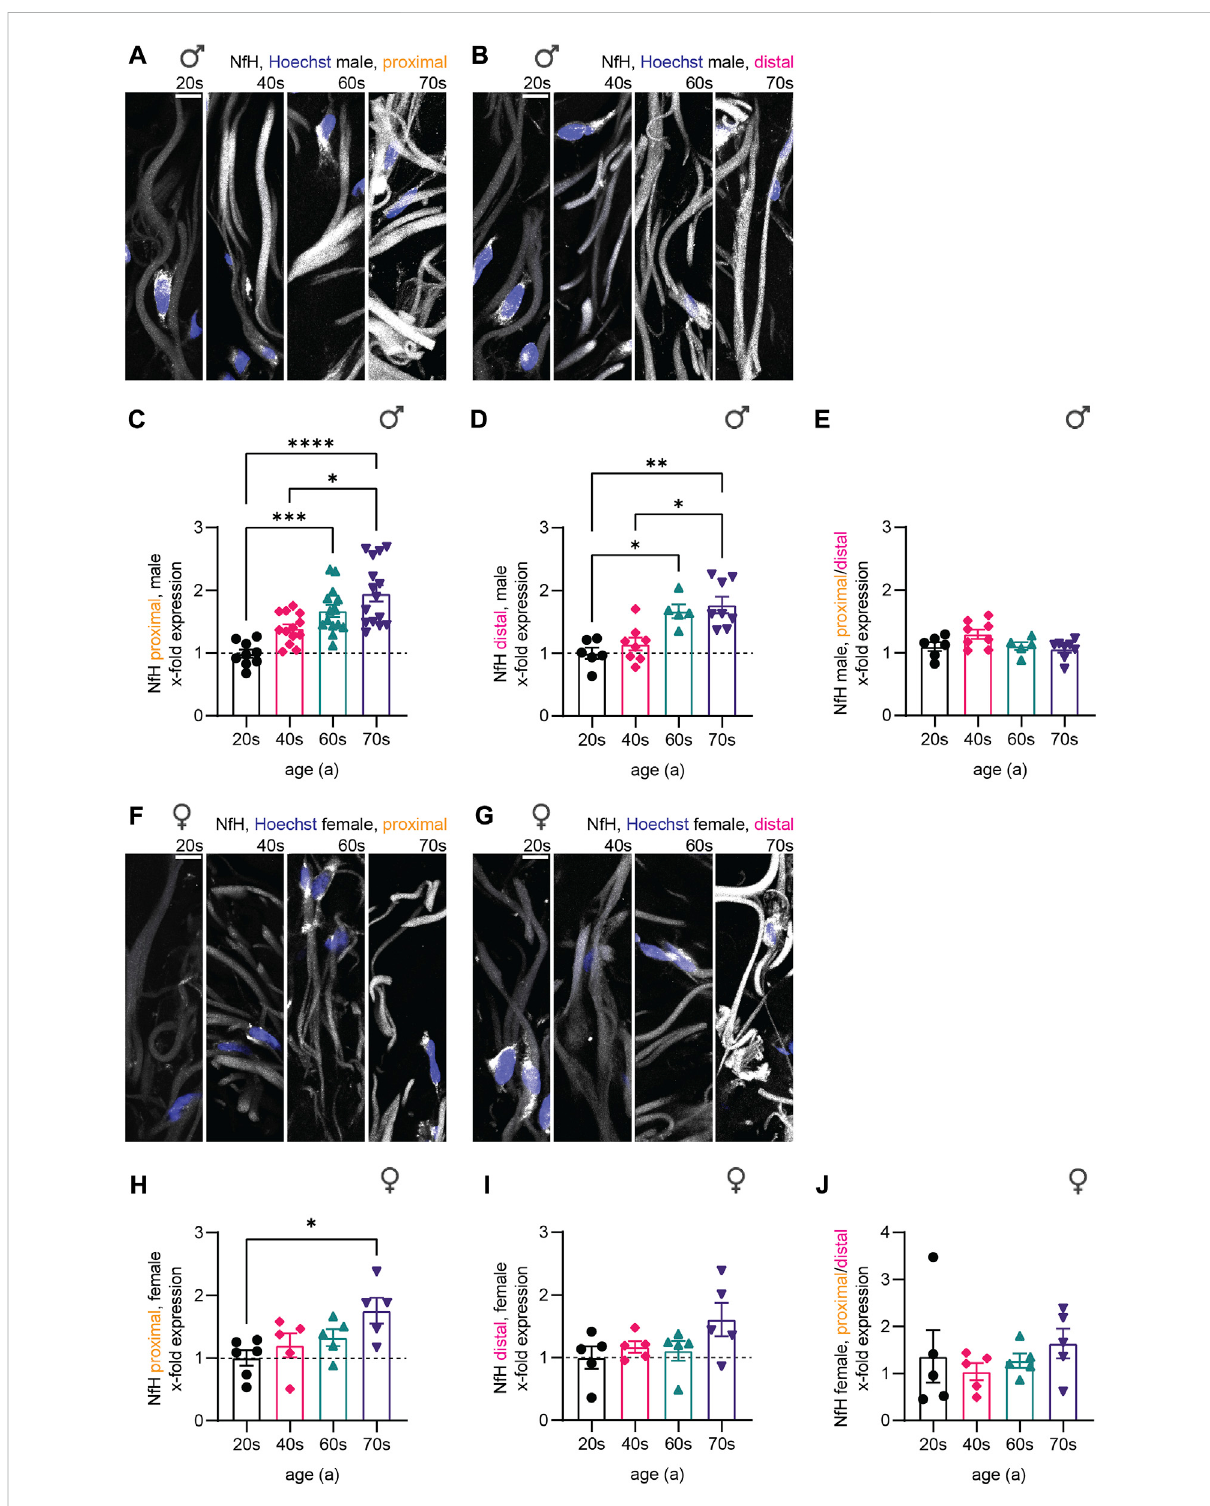
FIGURE 3 Quantitative immunostaining of human skin sections for NfH. (A,B,F,G) Confocal images of immunostaining for NfH (white) with nuclear stain (Hoechst,blue)foroneindividualofeachagegroup(fromlefttoright:20s,40s,60s,and70s)areshownforthe (A) proximalmale,the (B) distalmale, the (F) proximal female, and the (G) distalfemale sample set. (C,D,H,I) Quanti fi cation ofNfH intensity in sensory axons (x-fold normalized to average of 20s group) (3 images per individual, ≤ 20 axons per image, (C) n = 51 individuals in proximal male, (D) n = 27 in distal male, (H) n = 21 in proximal female, (I) n = 20 in distal female data). (E,J) Differences between the male and female proximal and distal samples were determined by calculating the NfH expression ratio for each individual. Scale bars in (A,B,F,G) are 10 µm. Points in graphs (C – E,H – J) represent on individuals. Data represent mean ± SEM. Kruskal – Wallis test with Dunn ’ s multiple comparisons test. * p < 0.05, ** p < 0.01, *** p < 0.001, **** p <